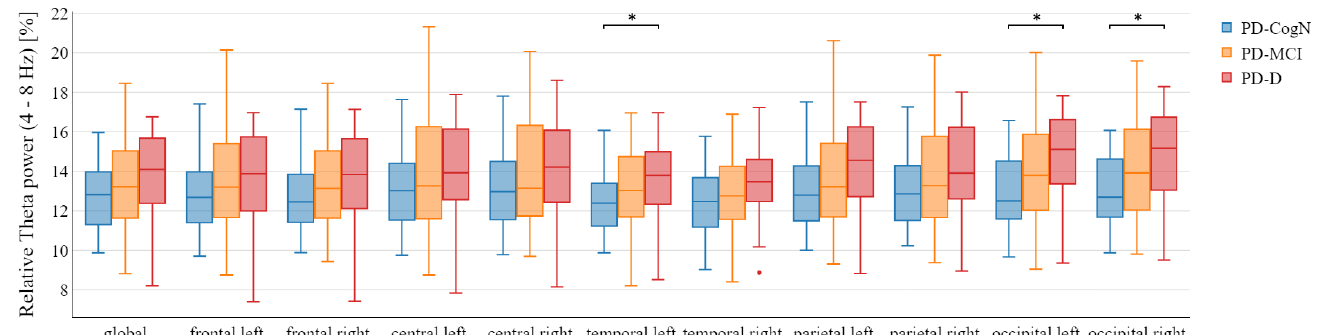
Figure 3. Relative theta power in the different areas between patient’s groups with statistical signifi- cance highlighted (* p < 0.05).